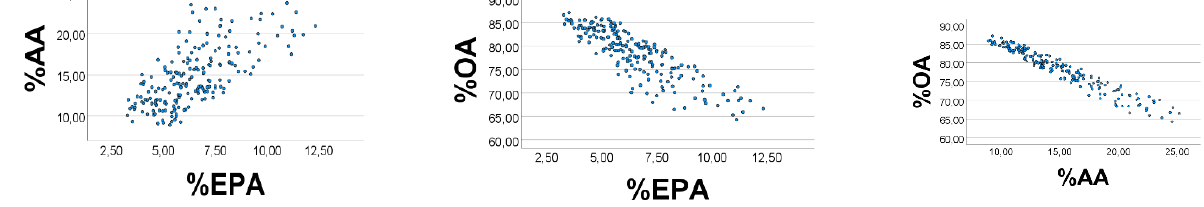
Figure 3. Effect of narrowing the OA ’ range upon associations between relative amounts of EPA ’ , AA ’ , and OA ’ , in a computer experiment. S = OA ’ + EPA ’ + AA ’ . RANDOM numbers ( n = 200) were used in lieu of true values. Ranges of EPA ’ , AA ’ , and OA ’ were 0.1–0.2, 0.3–0.4, and 1–3, respectively. %EPA ’ vs. %AA ’ : rho = 0.697; %OA ’ vs. %EPA ’ (%AA ’ ): rho = −0.852 (−0.964), p < 0.001 for all. Note: In the figure we have omitted the random number mark ( ‘ ) on the variables.